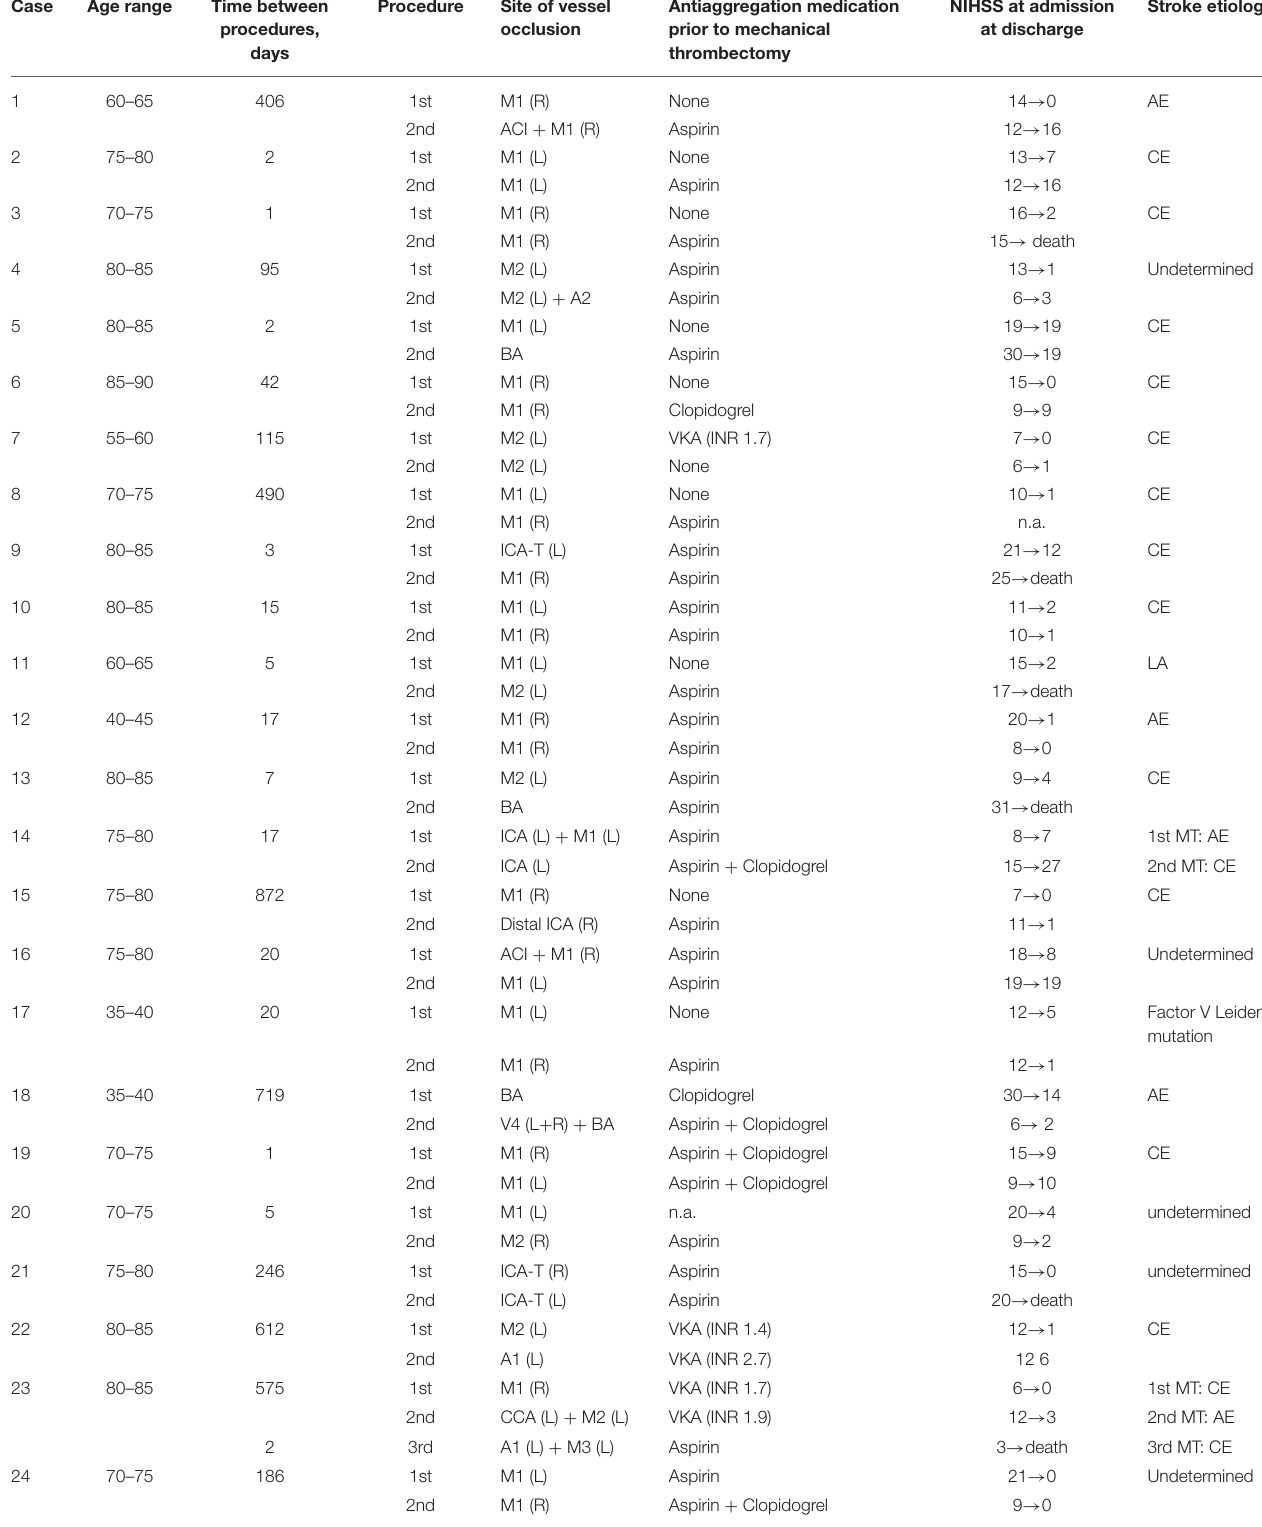
TABLE 1 | Detailed patient and procedural